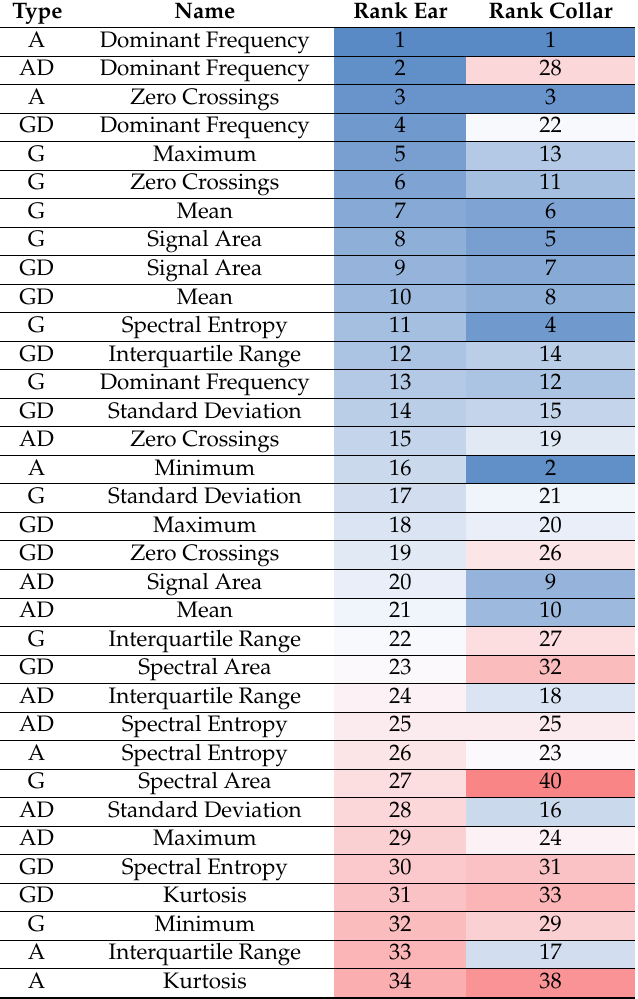
Table 3. Feature rankings and predictive values for collar and ear data using ReliefF. Colours indicate the feature rank from high (blue) to low (red). A: accelerometer, AD: accelerometer derivative (rate of change), G: gyroscope, GD: gyroscope derivative (rate of change). Type Name Rank